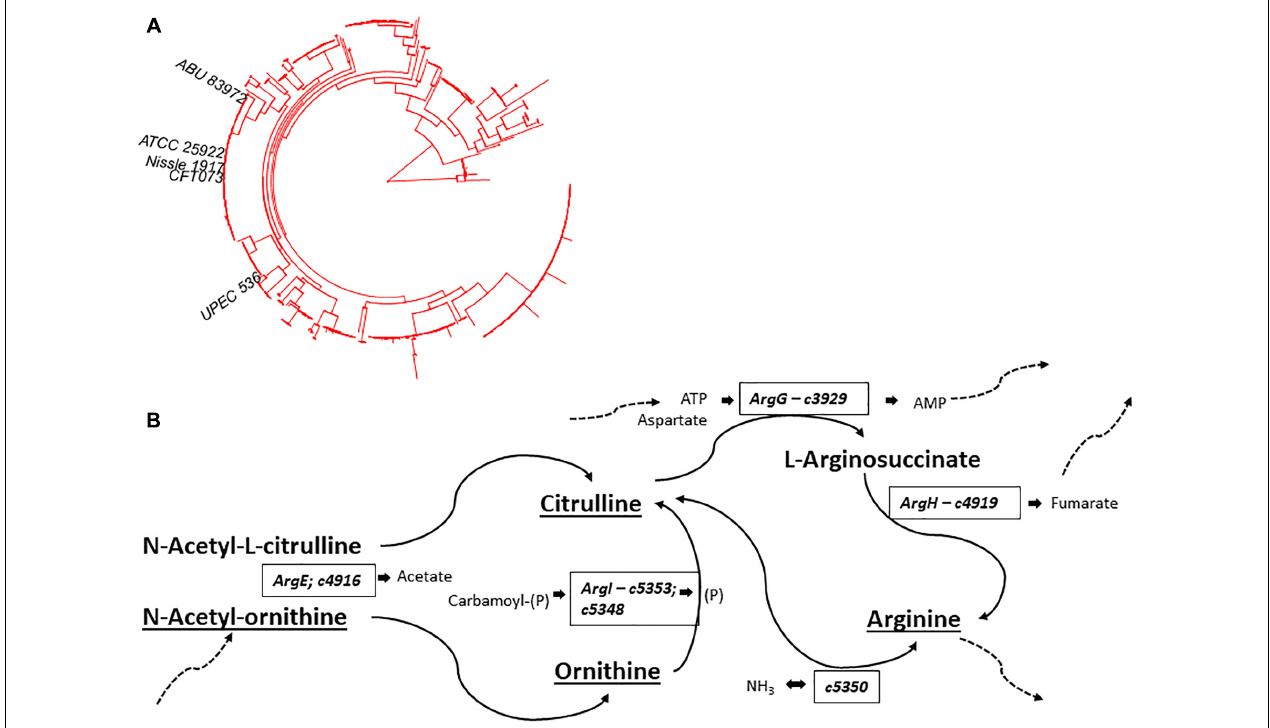
FIGURE 5 | (A) Phylogenetic position of B2 strains in Studies 2 and 3 (B2-focussed and validation studies) on the B2 phylogroup phylogenetic tree – notice the thigh grouping of NCTC12241/ATCC25922, Nissle 1917, and CFT073. (B) Schematic overview of Arginine biosynthesis relevant gene products with E. coli CFT073 as model. Compounds identified and annotated in this study are indicated by underlining. Additional substrates and products are indicated in small lettering adjacent to relevant enzymes. Dashed arrows indicate linkage to additional metabolic pathways. Comparative analysis showed identical Arginine deimidase (c5350 - enzyme EC 3.5.3.6) to be present in B2 strains Nissle, CFT073 and NCTC12241/ATCC25922. Identical amino acid sequences were also observed across these strains for enzymes EC 6.3.4.5 (ArgG – c3929), EC 4.3.2.1 (ArgH – c4919), EC 2.1.3.3 (ArgI – c5353; c5348) & EC 3.5.1.16 (ArgE – c4916). Thus, E. coli strains Nissle 1971, ABU87932 and NCTC12241/ATCC25922 share all indicated gene products whilst E. coli MG1655 lacks an orthologue of c5350 to interconvert Arginine and